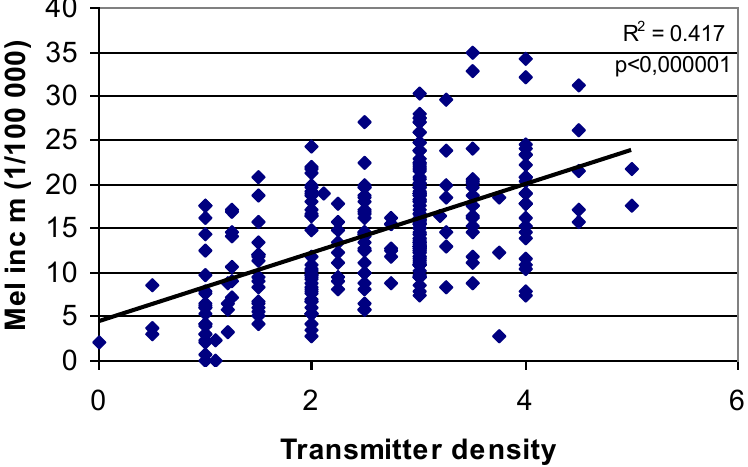
Figure 15. Melanoma incidence vs . the number of covering FM radio transmitters in Sweden [10].